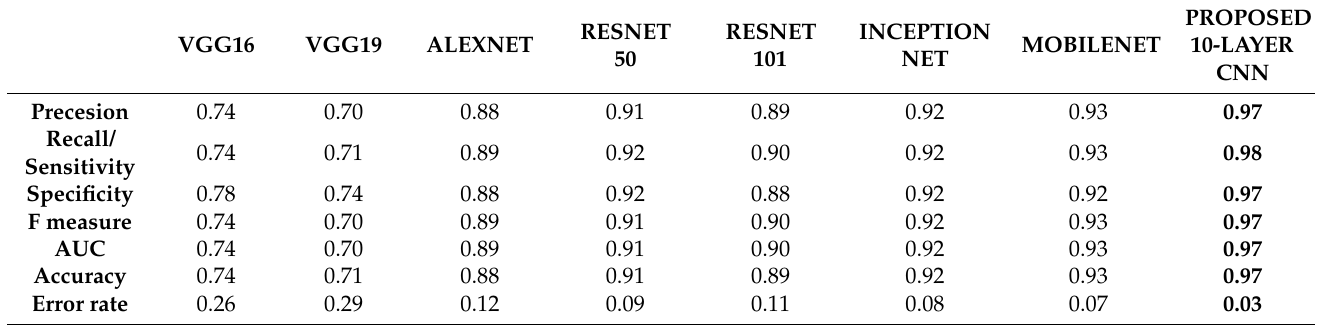
validation phase with a lower error rate. On the other hand, the maximum accuracy value indicates optimal results for the model